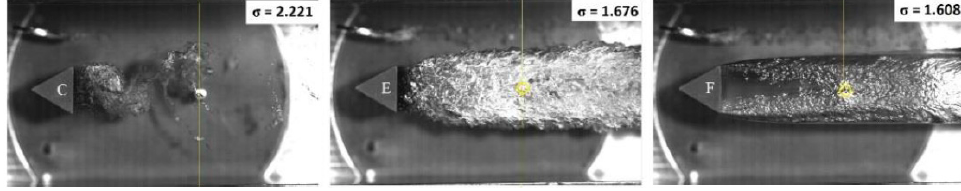
Figure 8. Visualization of cavitation structures in cavitation tunnel. Credit: Le and Iga [31].